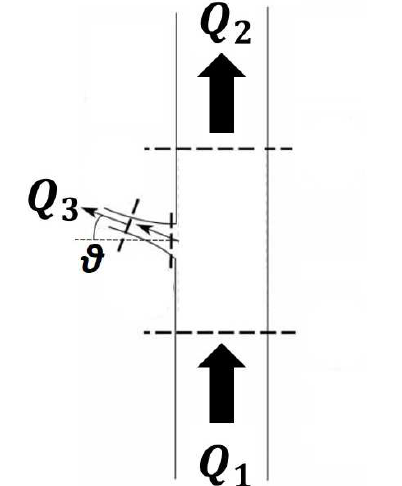
Fig. 1. Definition of the three flow rates in the pipe: Q 1 is the flow rate in the pipe before the orifice, Q 2 the flow rate in the pipe after the orifice, Q 3 the flow rate of the jet.